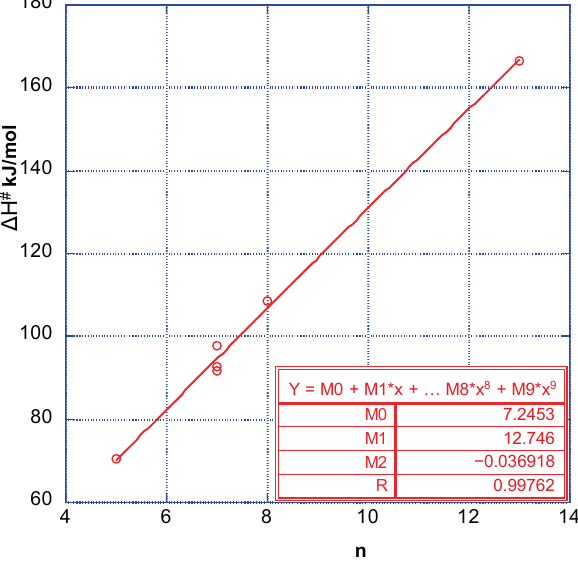
Figure 1. ∆ H # plotted as a function of the corresponding vibrational quantum number, n. The six points from Table 1 were fitted to a second order function. The result is given within the graph